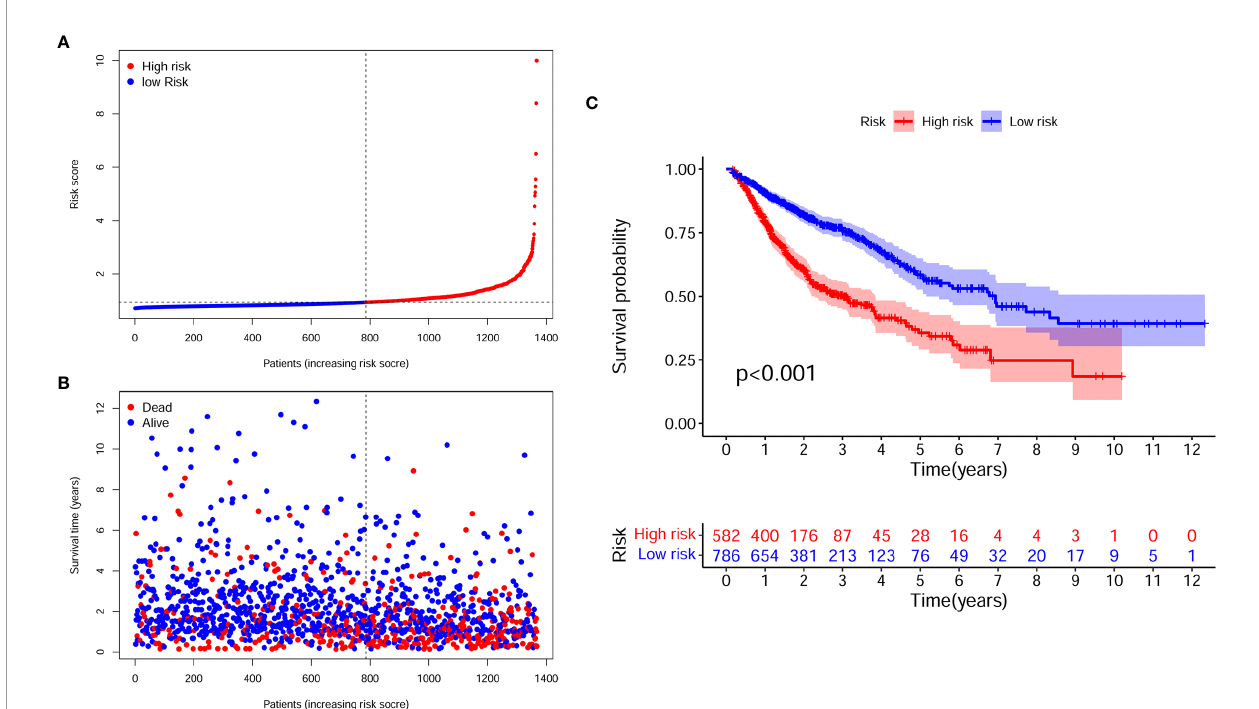
FIGURE 4 | The assessment of prognostic model for survival outcomes. (A) As the number of patients increased, the risk scores of the prognostic model were raised. (B) As the number of patients increased, the number of patient deaths signi fi cantly increased. (C) The survival time was signi fi cantly longer in the low-risk group than in the high-risk